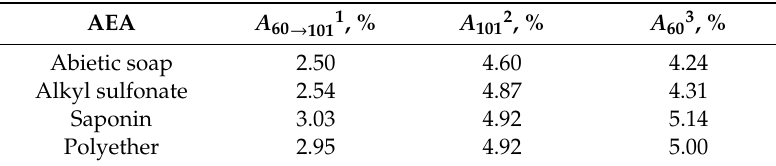
Table A1. Tests results cited from Li’s research and a reanalysis